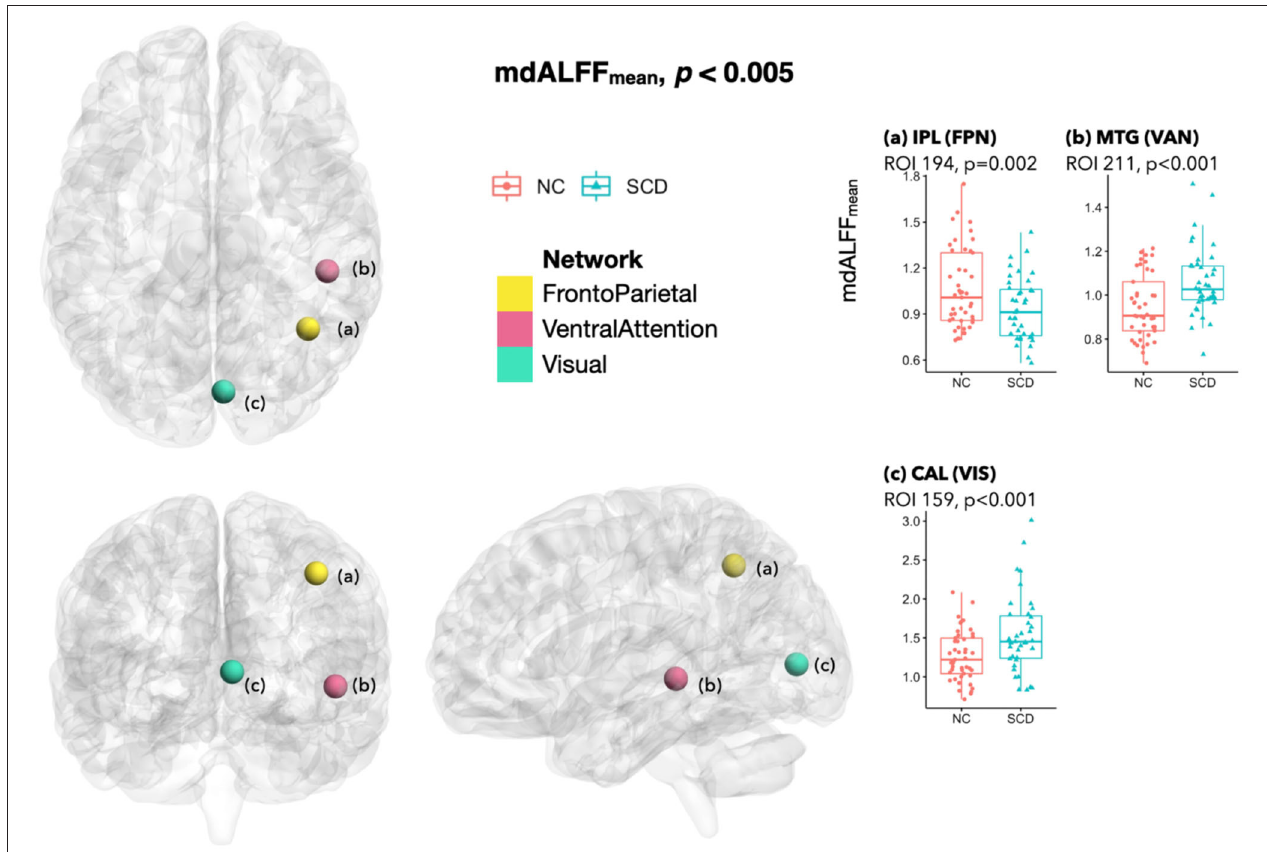
FIGURE 2 | Differences of mdALFF mean between SCD and NC. When comparing the SCD group with the NC group, a significant decrease of mdALFF mean at a p < 0.005 was found at ROI(a) in right IPL of FPN. In contrast, the mdALFF mean increased in ROI(b) in right MTG of VAN and ROI(c) in right CAL of VIS. In addition, a marginal decrease of mdALFF mean was observed at a cFPN ROI in right lobule VI, two cDMN ROIs in left Crus I/II, and a AUD ROI in right Rolandic area ( p -value between 0.005–0.01; not shown in the figure). The anatomical location of each ROI was referred to the Automated Anatomical Labeling atlas (Tzourio-Mazoyer et al., 2002 ), and their functional network attribution was classified by Seitzman et al. (Seitzman et al., 2020). SCD, subjective cognitive decline; NC, normal control; mdALFF mean , mean of the mean dynamic amplitude of low-frequency fluctuation; ROI, region of interest; IPL, inferior parietal lobule; FPN, frontoparietal network; MTG, middle temporal gyrus; VAN, ventral attention network; CAL, calcarine fissure and surrounding primary visual cortex; VIS, visual network; cFPN, frontoparietal network in the cerebellar regions; cDMN, default mode network in the cerebellar regions; AUD, auditory